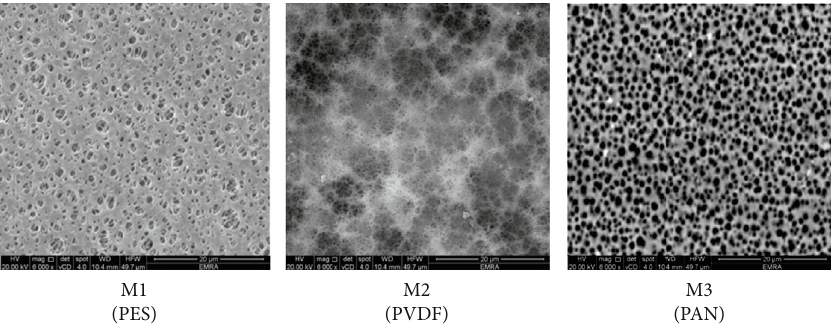
Figure 4: SEM photos for prepared membranes.